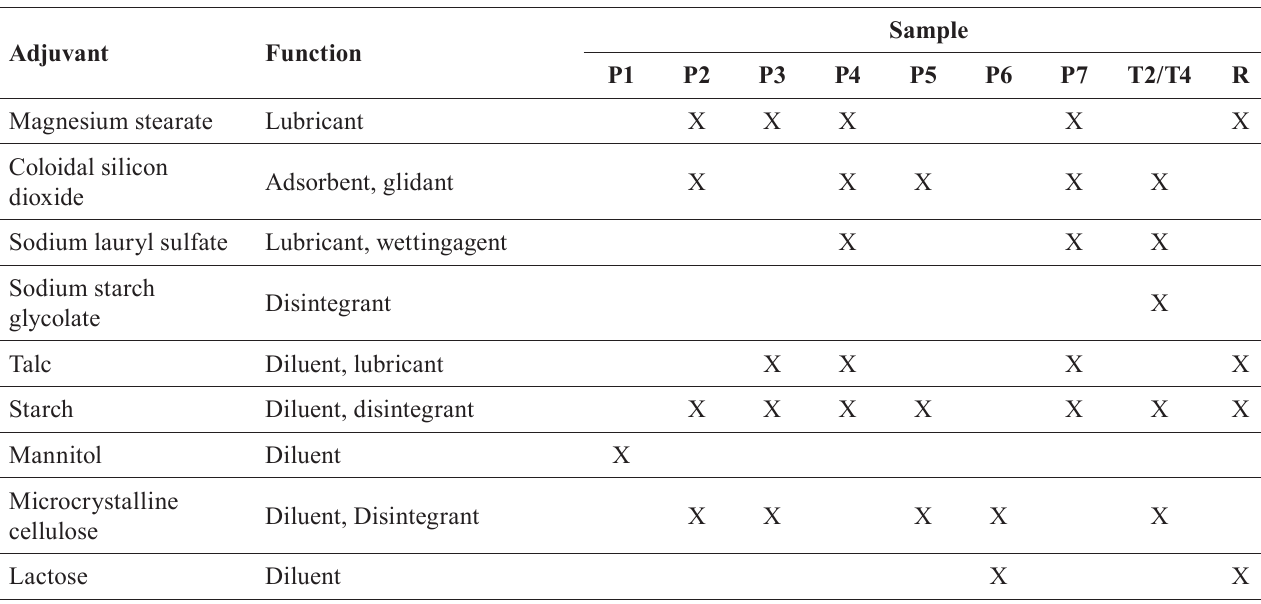
TABLE II - Declared excipient composition of furosemide capsules contained in compounding capsules (P1, P2, P3, P4, P5 P6 and P7) and the reference medicinal product (R) compared to our in-house capsules (T2 and T4)